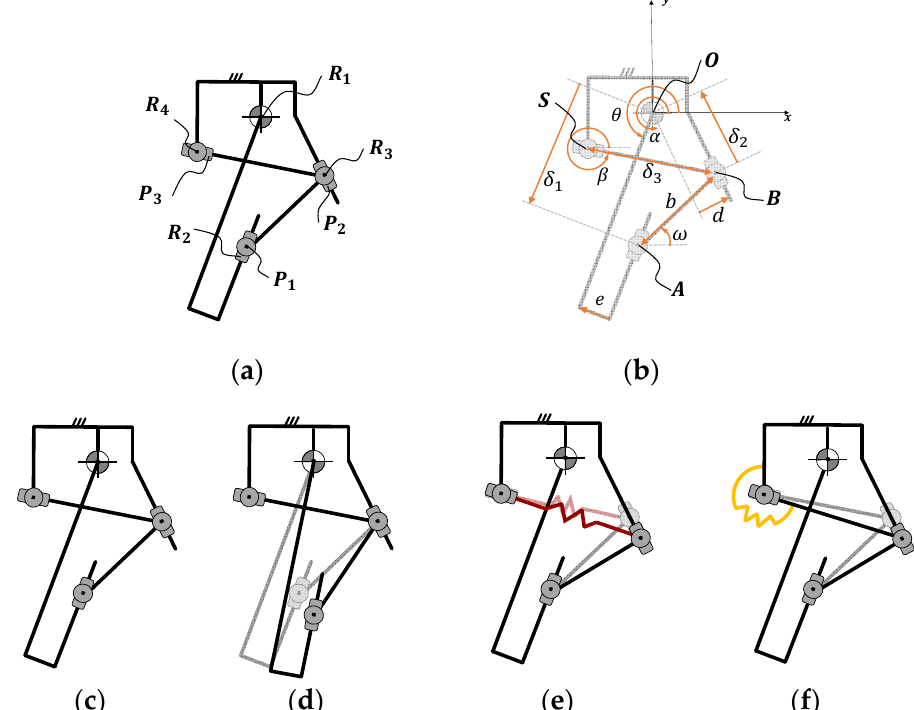
Figure 1. Kinematic diagram of the actuator with passive variable transmission. The proposed actuator is based on two closed kinematic chains acting in parallel ( a , b ). These parallel chains result in a system with two degrees of freedom: one is the rotation of the joint R 1 ( c , d ), and the other is the translation of the joint P 3 . The position of joint P 3 can be regulated with either a linear spring ( e ) or a torsional spring ( f ).